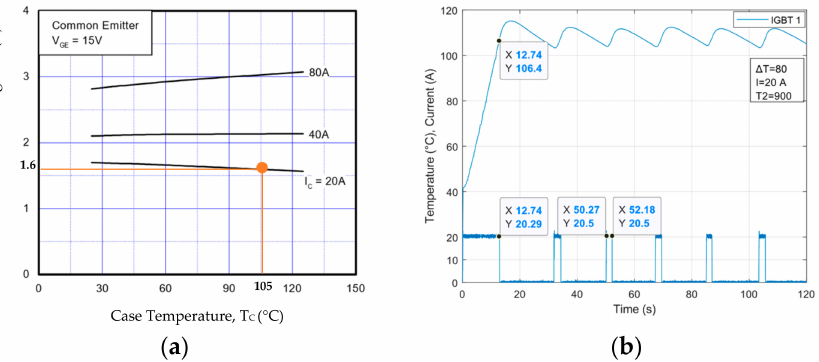
Figure 10. ( a ) IGBT case temperature, collector-emitter voltage, current correlation; ( b ) recorded current and the temperature characteristic of a single IGBT for the chosen